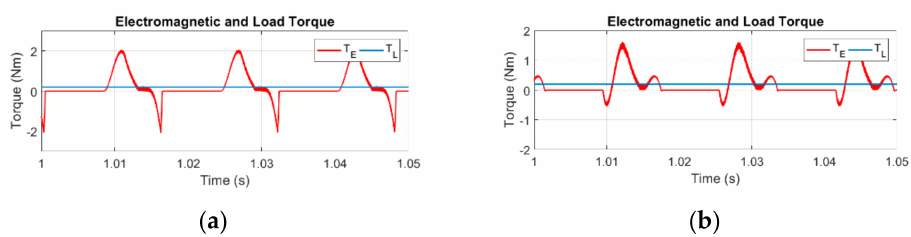
Figure 14. Electromagnetic torque T E compared to the load torque T L in case of 900 rpm and 10% of rated load under Hall-effect position sensors A and C breakdown fault. ( a ) Defective sensors A and C at high state; ( b ) Defective sensors A and C at low